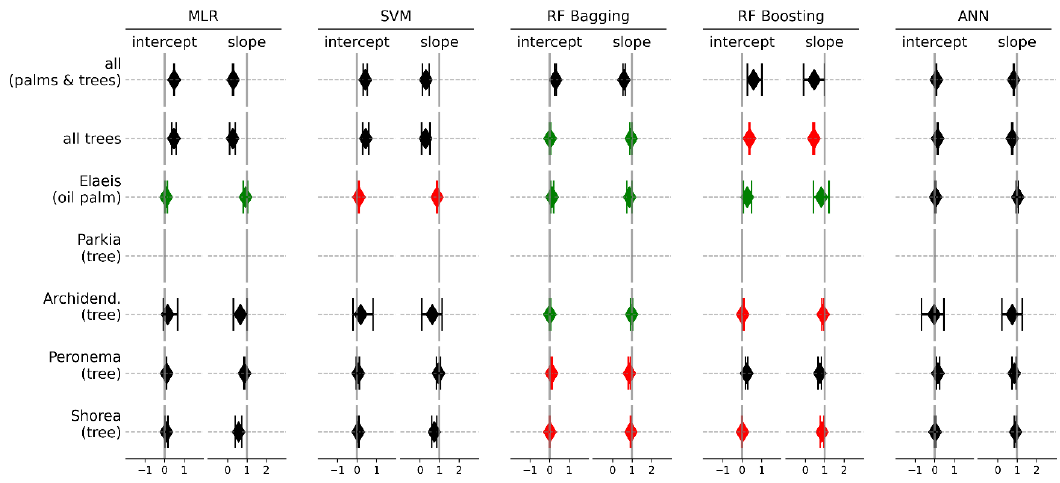
Figure 6. The 99% confidence intervals of slope and intercept from model II Passing-Bablok regression for sap flux. The results in green show no significant bias between measured and predicted values. The results indicated in red fulfilled the assumptions of linearity but a significant difference between measured and predicted values was found. The results displayed in black did not meet the assumption of linearity and are therefore not to be